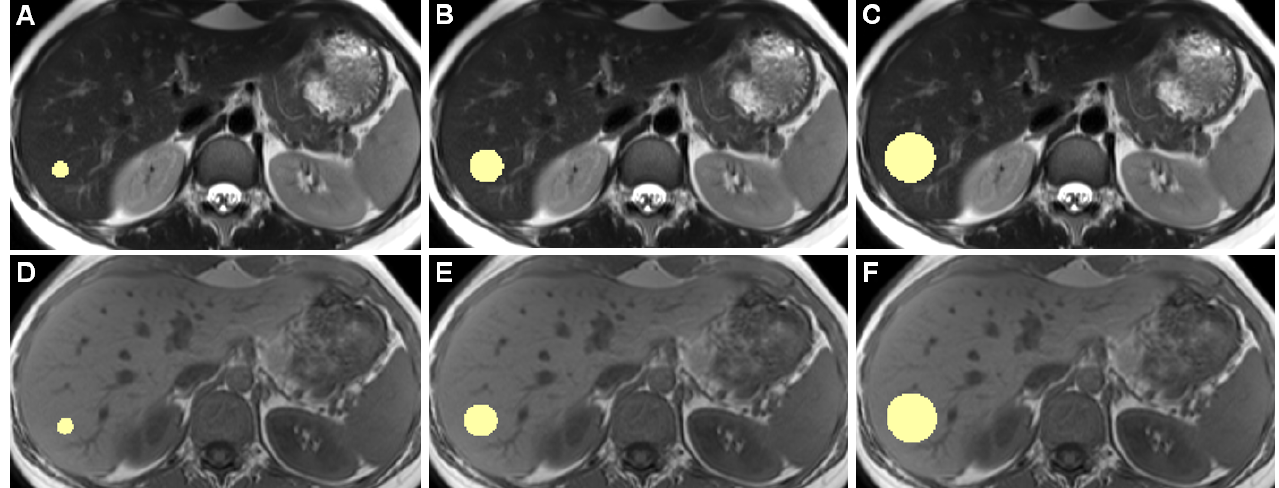
Figure 1. Example slices of 3D ROIs of one healthy individual, acquired on the 3 Tesla I scanner, are shown. Images ( A – C ) are from a T2-weighted TSE HASTE sequence, ( D – F ) are from a T1-weighted GRE FLASH sequence. ( A , D ) show 10-mm diameter ROIs, ( B , E ) 20 mm, and ( C , F ) 30 mm ROIs. While drawing ROIs manually throughout all included patients, we aimed to only include hepatic parenchyma while excluding any apparent blood vessels or bile ducts.